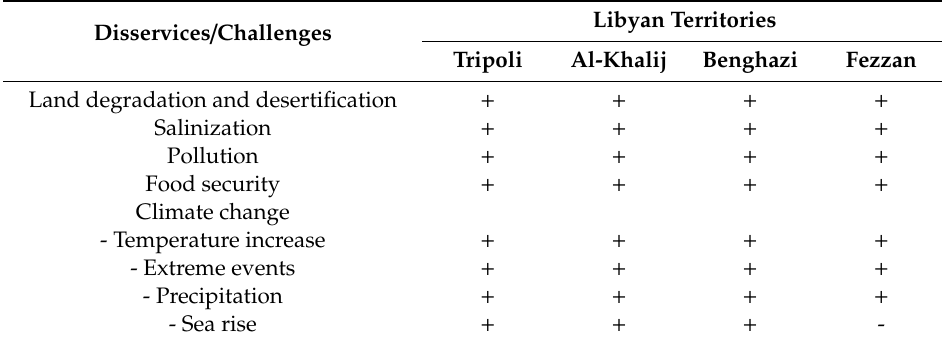
Table 14. Soil-related disservices and challenges by territories.